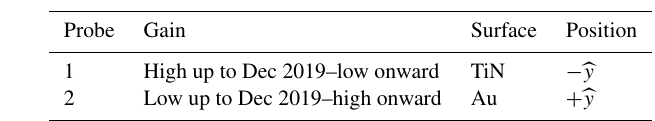
Table 1. List of differences between the two LPs on each Swarm satellite. The probe position is defined with respect to the spacecraft coordinate system, where (cid:98) x is along the fly direction, (cid:98) y horizontally crosses the satellite toward local dusk, and (cid:98) z points toward the